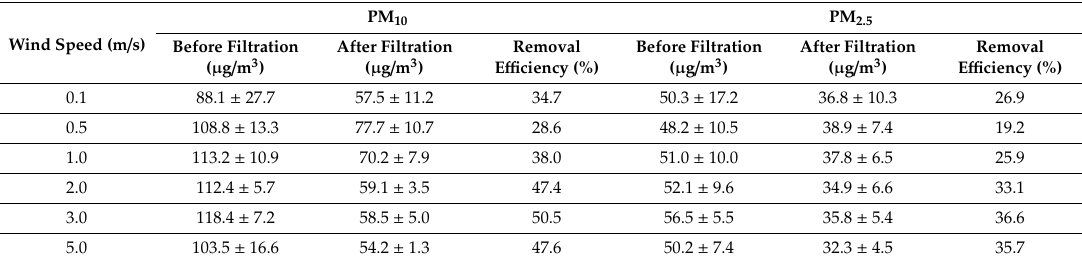
Table 3. Average fine PM removal e ffi ciency of the ACF filter for di ff erent wind speeds at an ACF depth of 400